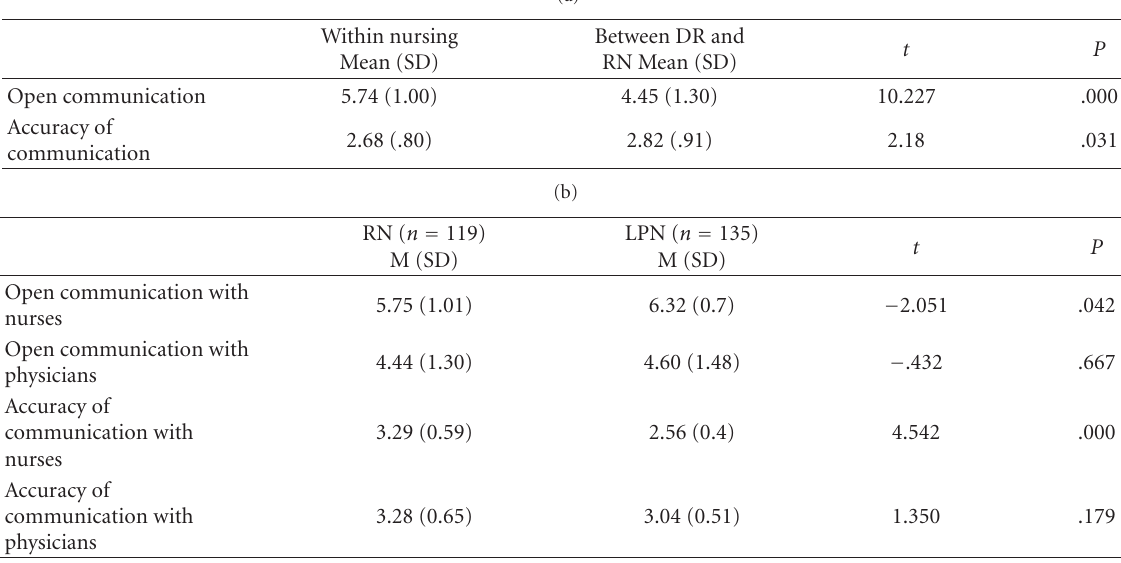
Table 2: Di ff erences in openness and accuracy of communication.